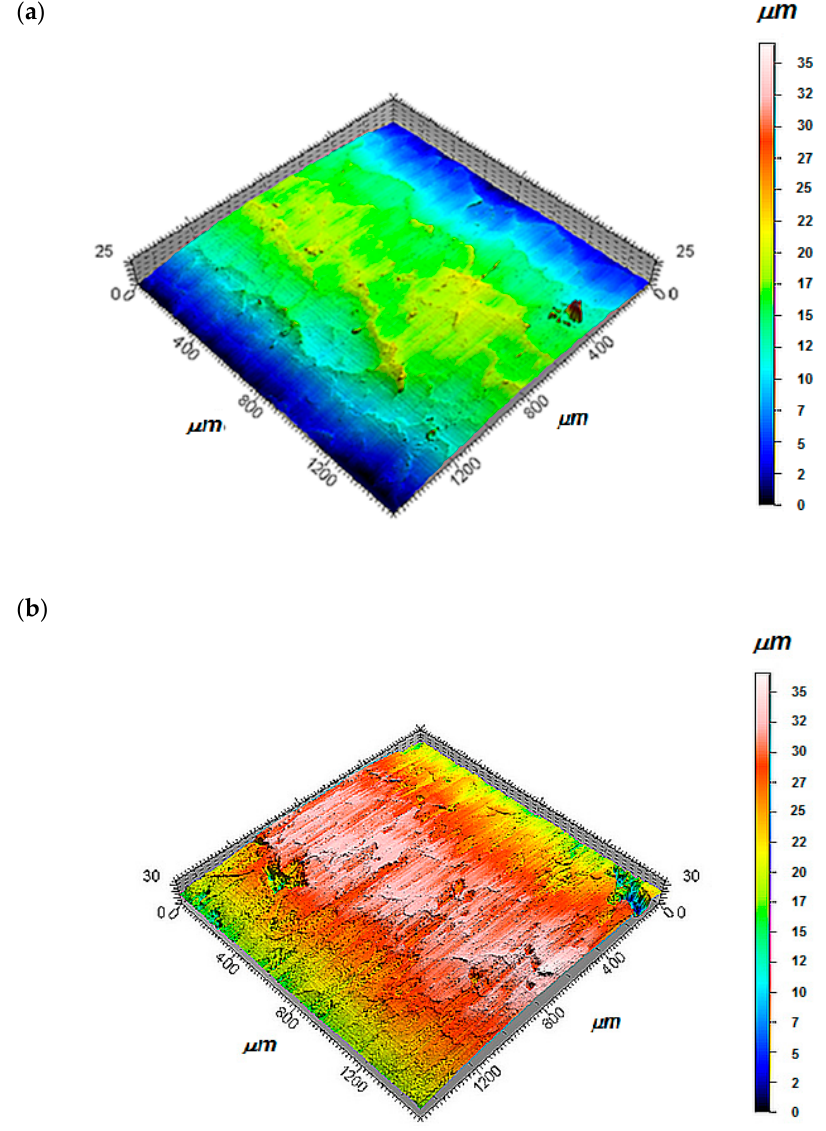
Figure 12. The topography of the burnished surface of the coatings: alloy ( a ) and composite ( b